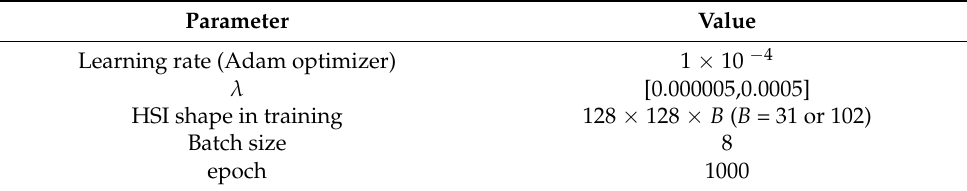
Table A2. Table of hyperparameters in training.